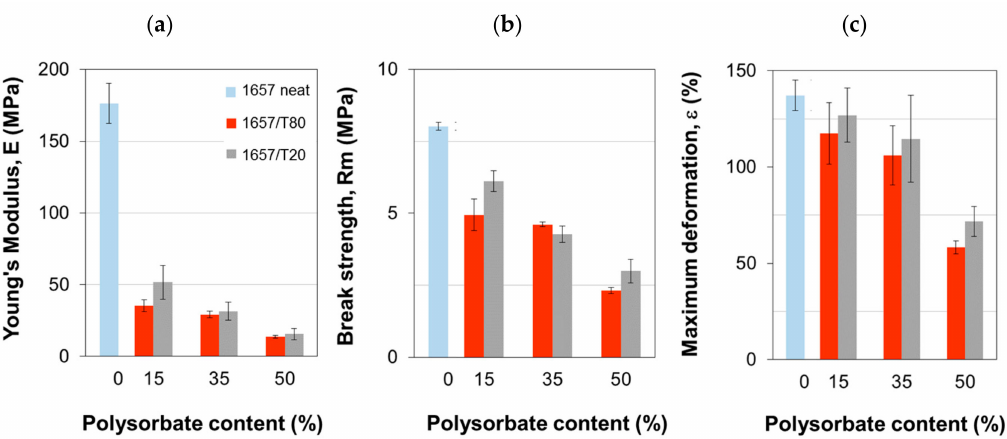
Figure 5. Mechanical properties of the Pebax ® 1657 and Pebax ® 1657 / polysorbate films. ( a ) Young’s Modulus; ( b ) break strength; ( c ) maximum